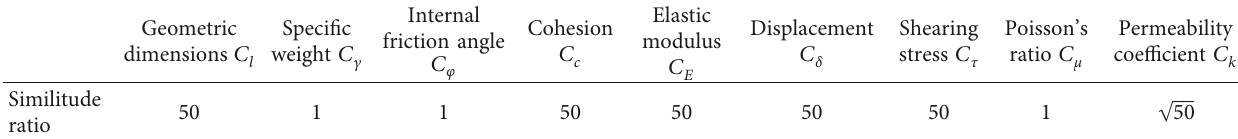
Table 3: Similitude ratio of geotechnical mechanical